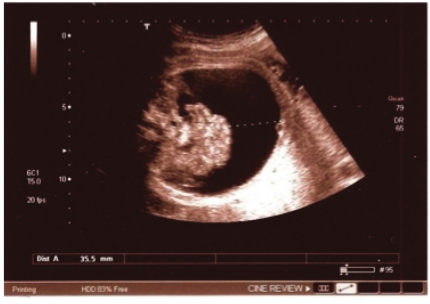
Figure 2: Urinary ascites.